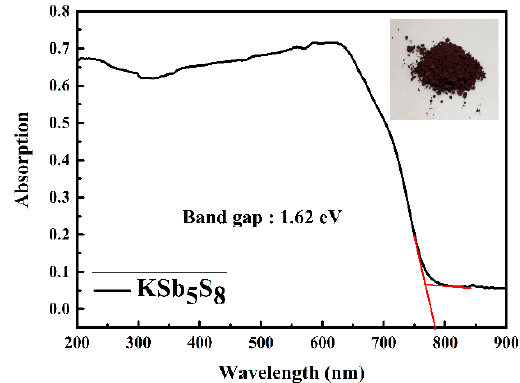
Figure 4. UV-visible absorption spectra of KSb 5 S 8 sample (inset: Dark red ).